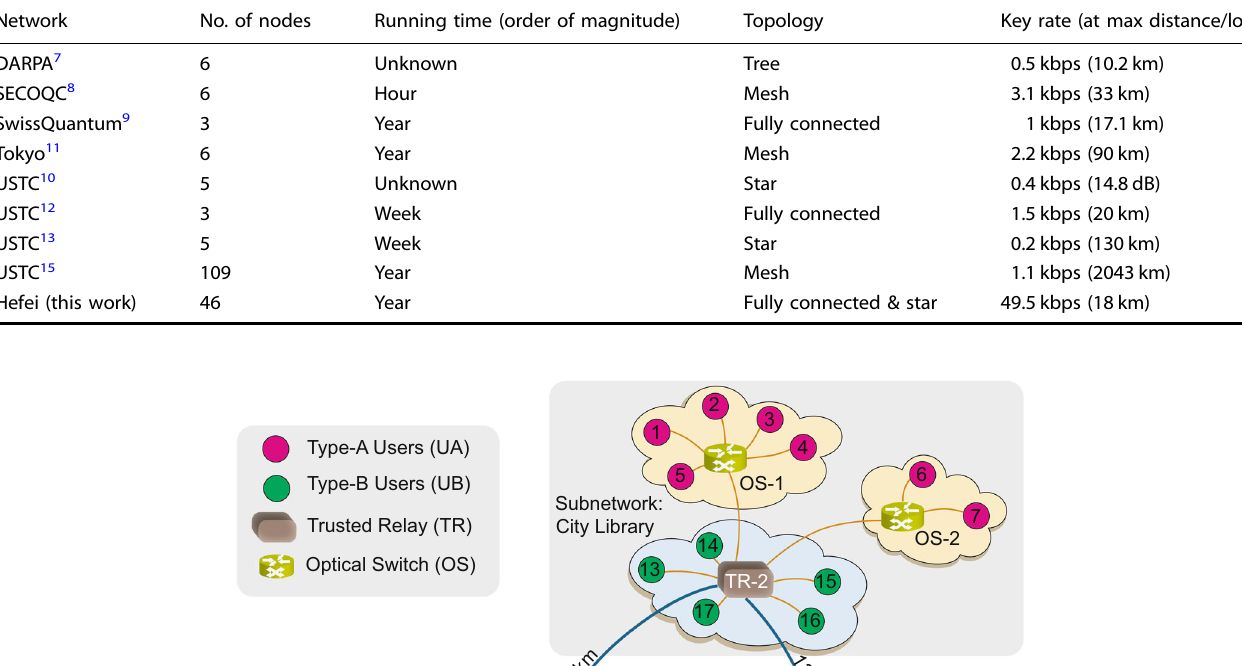
Table 1. Existing QKD network implementations. Network